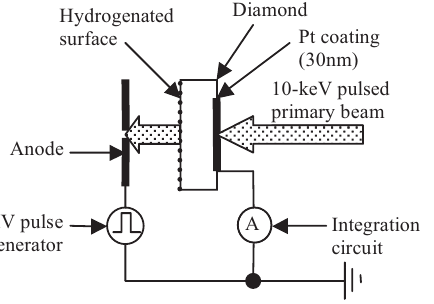
FIG. 3. Diagram of the experimental system. The primary beam’s spot was about 1 mm 2 , the diamond’s thickness was 300 (cid:1) m , and the gap between the H surface and the anode was 250 (cid:1) m .